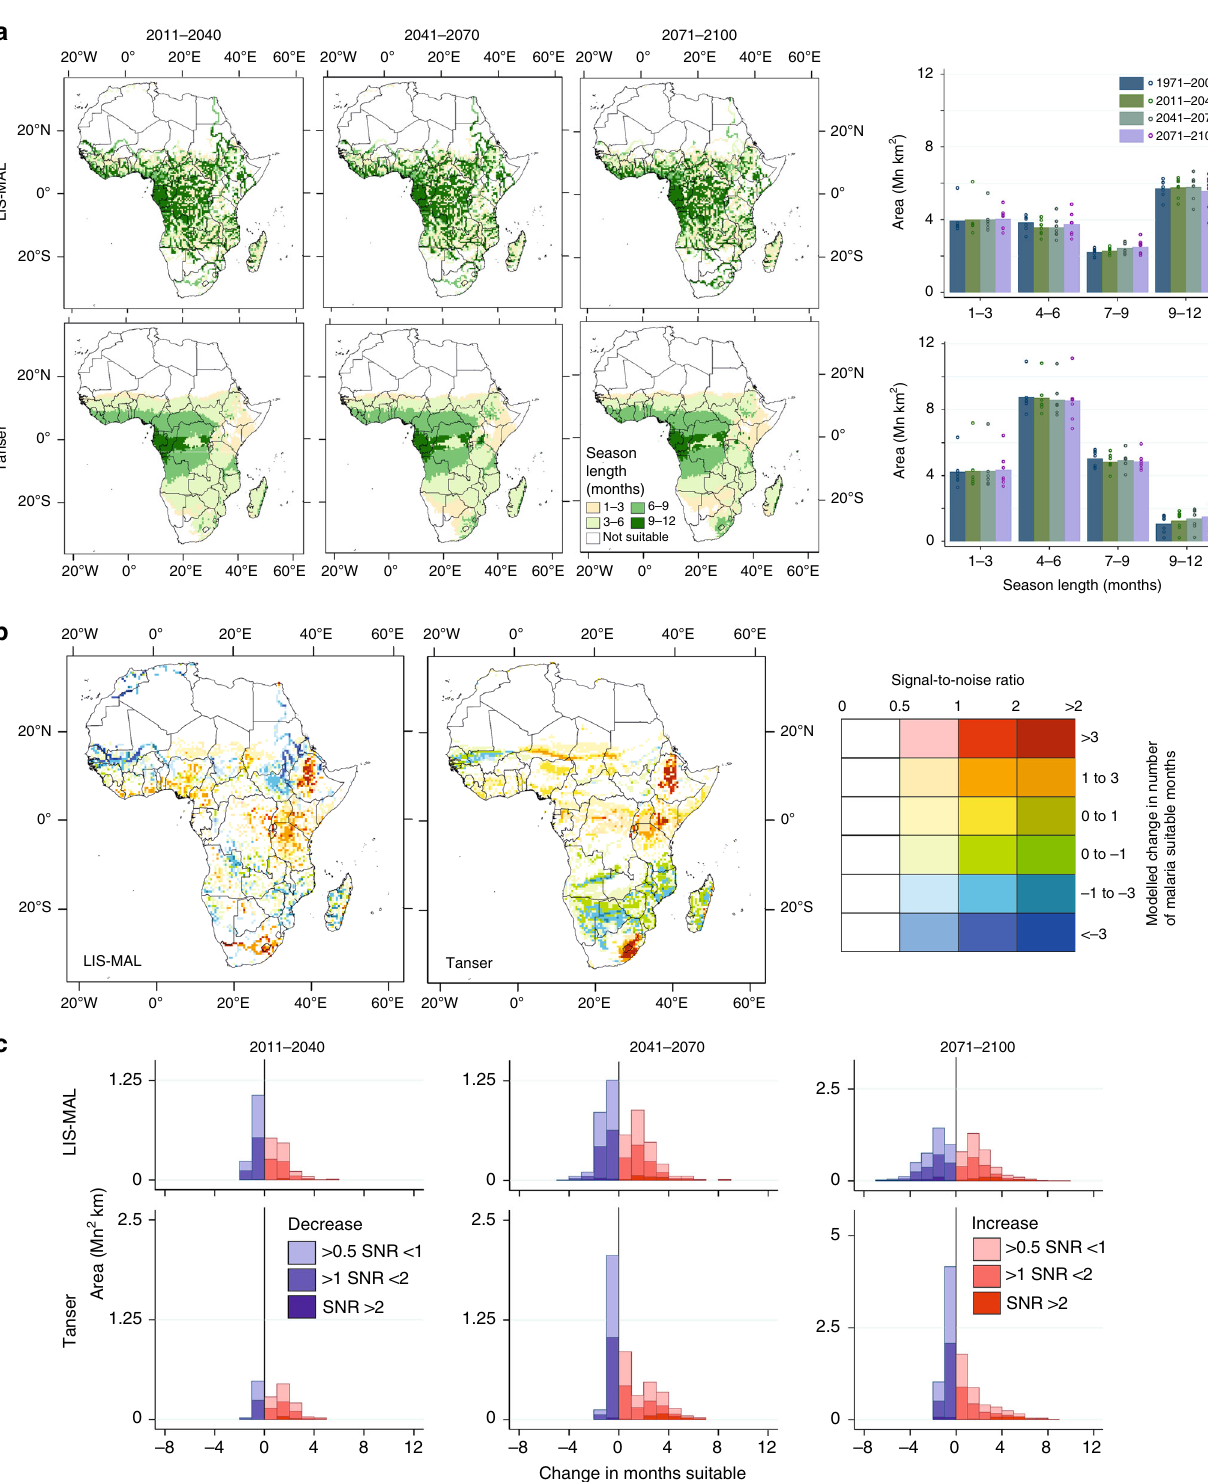
Fig. 3 Future predictions of climatic suitability for malaria transmission. a Mean model predictions for LIS-MAL and the Tanser rainfall threshold at each time step with a summary of areas in 3-month categories. Bars indicate mean of model estimates ( n = 7); points indicate individual model estimates. b Mean changes in malaria hydro-climatic suitability predicted across forcing models by LIS-MAL and Tanser models between 1971 – 2005 and 2071 – 2100, where the signal-to-noise ratio >0.5. Different saturations indicate the signal-to-noise ratio across the seven projections, with the noise de fi ned as the standard deviation of estimates across the projections. c Stacked histograms showing changes number of months climatically suitable up to 2071 – 2100 split into categories of signal-to-noise ratio from b . For changes between all periods and all hydrological models see Supplementary Figs. 6 –